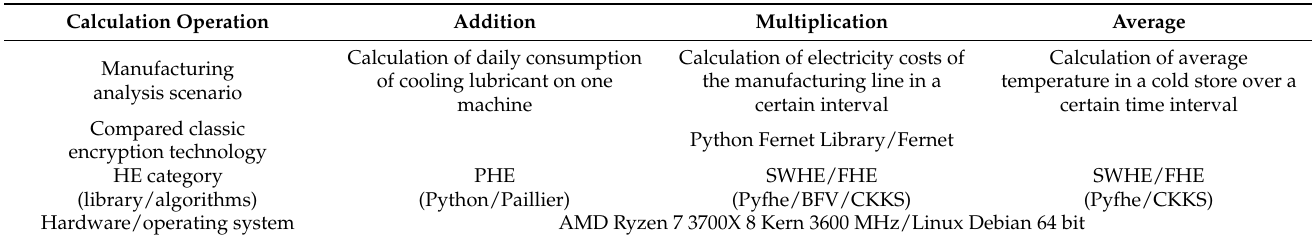
Table 2. Experimental setup to validate the potential and challenges of homomorphic